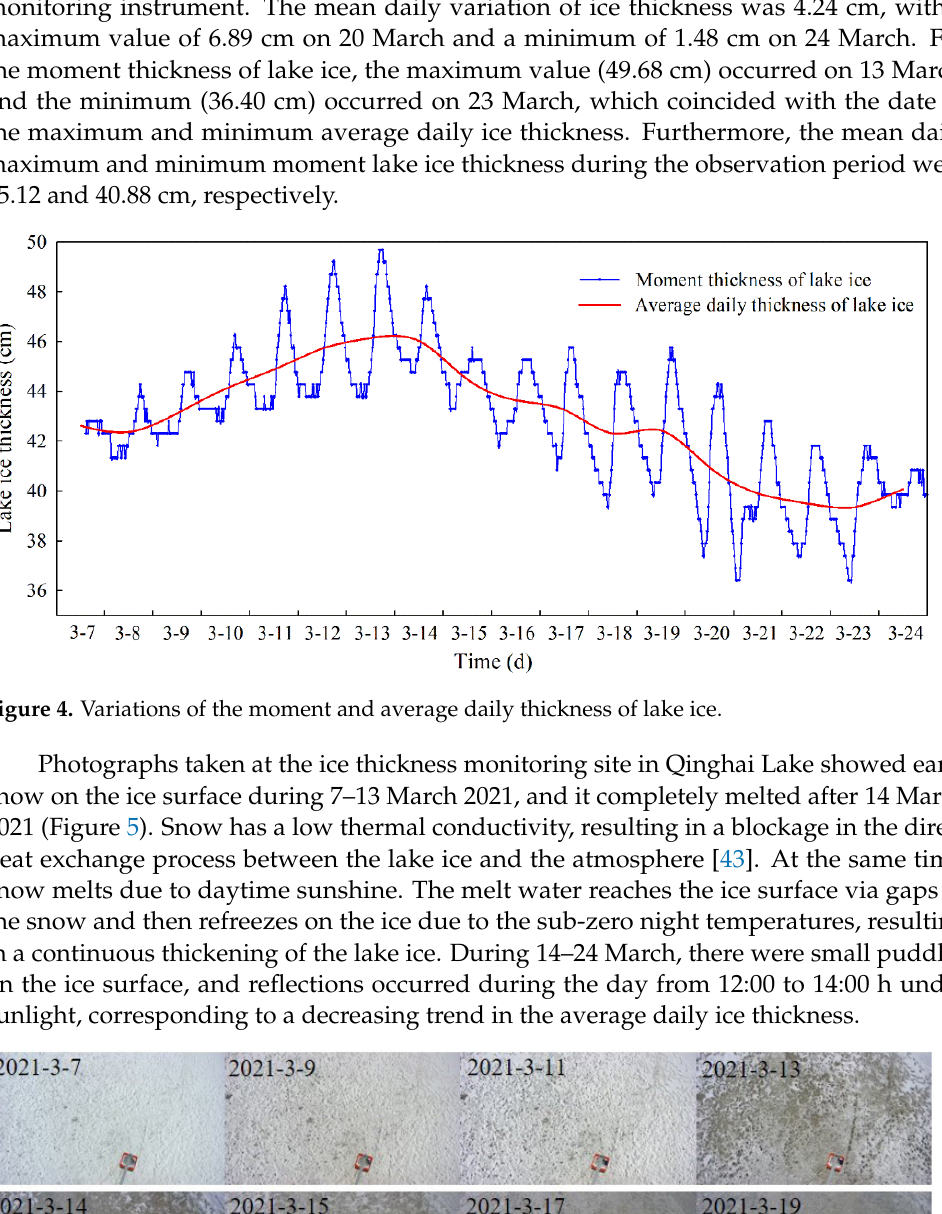
Figure 5. Photographs of the ice surface below the GPR ice thickness monitoring system.